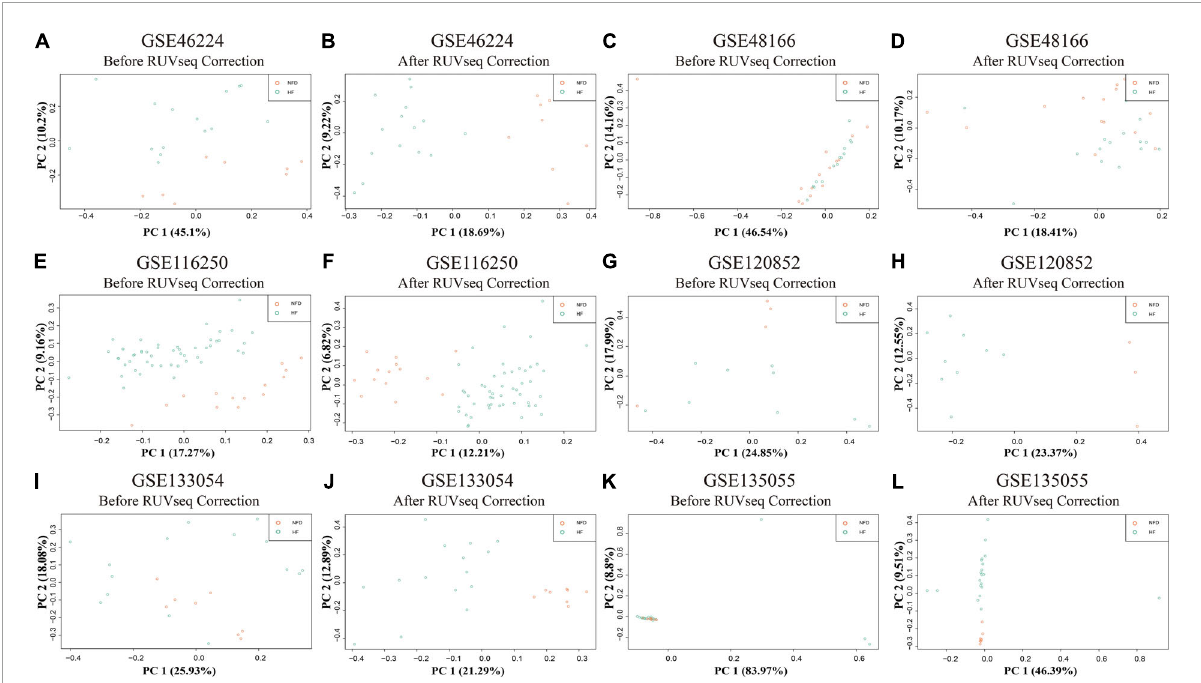
FIGURE3 PCA plots of the six RNA-seq datasets in GEO database. PCA distribution plots showed that complete separation between patients with HF and NFD samples was observed in five datasets after RUVSeq correction, except GSE48166 (C,D) , namely, GSE46224 (A,B) , GSE116250 (E,F)